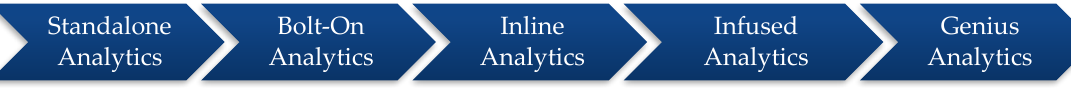
Figure 9. Logi Analytics Maturity Model—five stages of analytics maturity. Source: own study based on LAMM.